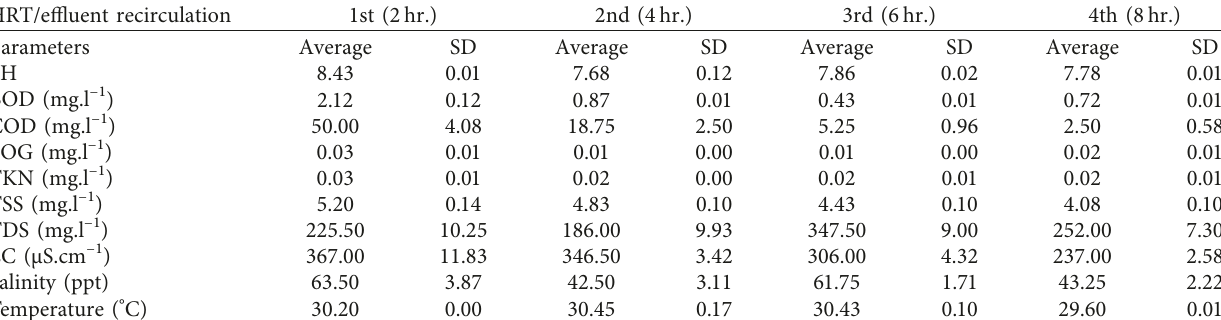
Table 5: The average concentrations of pollutants in the wastewater after passing through the aeration HSFCWs system. HRT/effluent recirculation